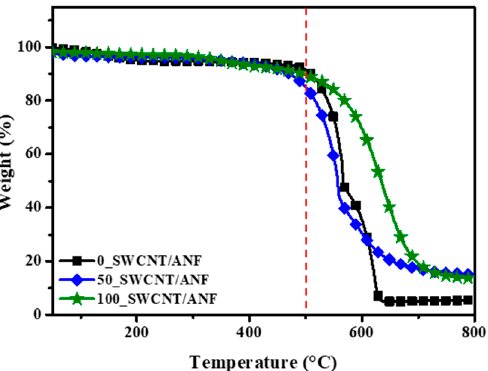
Figure 4. TGA plots of 0, 50, and 100_SWCNT/ANF samples. The red dotted line indicates 500 °C.